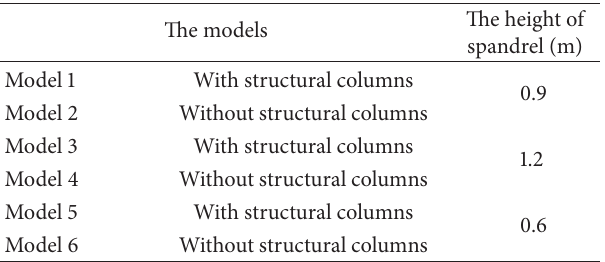
Table 1: The models. The